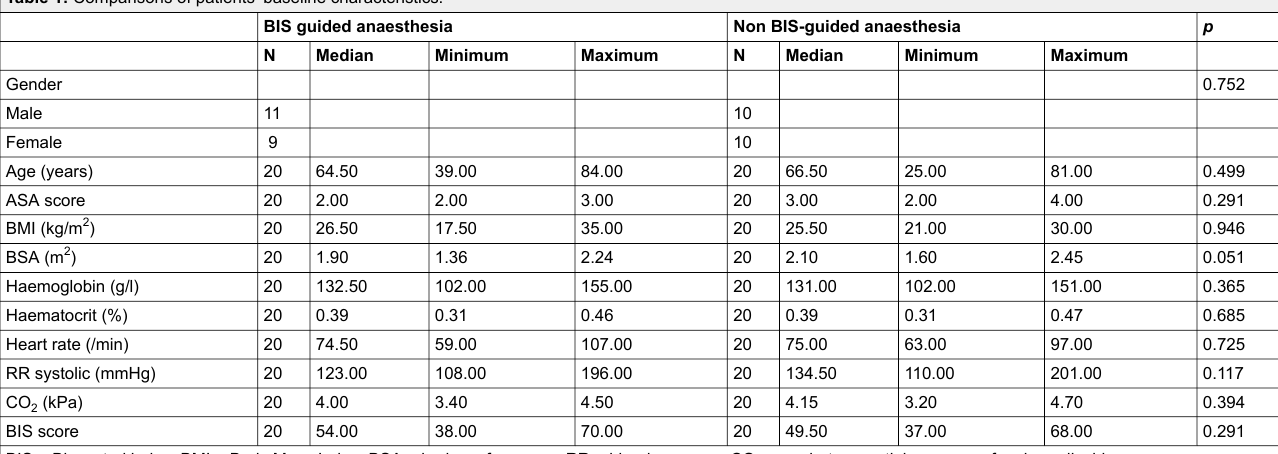
Table 1: Comparisons of patients’ baseline characteristics.